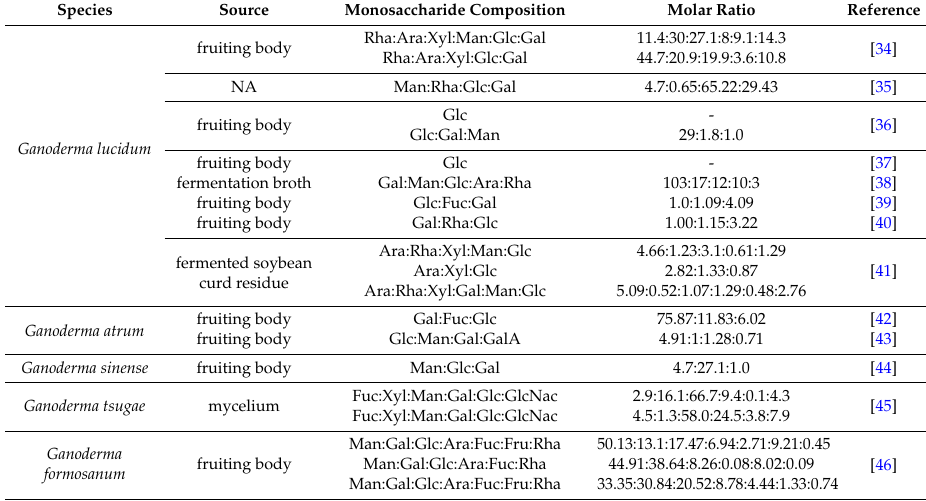
Table 2. Monosaccharide composition and molar ratio of polysaccharides from Ganoderma species. Species Source Monosaccharide Composition Molar Ratio Reference fruiting body